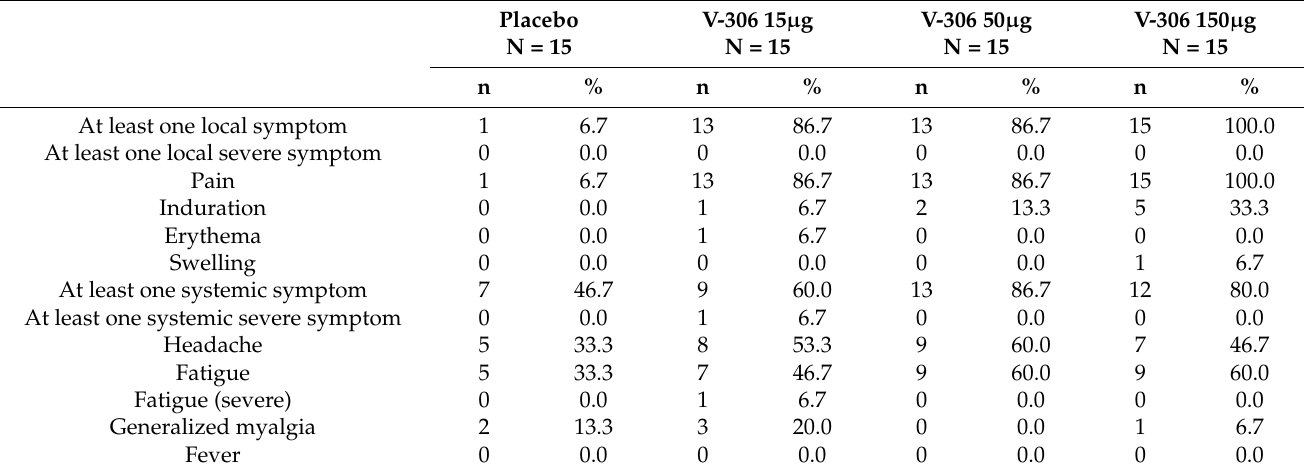
Table 1. Number and percentage of subjects reporting solicited local and systemic signs or symptoms during 7 days after the two administrations (Days 0 and 56) in the pooled placebo groups and in the vaccine groups (V-306 15 µg, 50 µg and 150 µg).